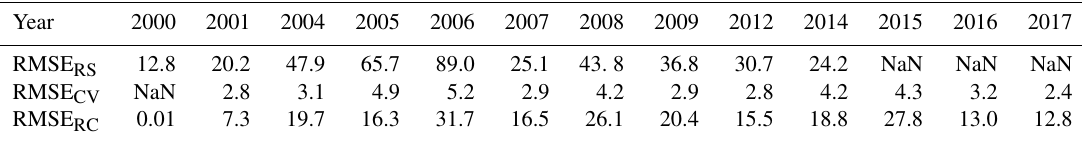
Figure 3. The aggregated in situ observational p CO 2 data in 0 . 5 ◦ × 0 . 5 ◦ grid boxes in the SCS in the 13 summers during the years 2000– 2017. Table 2. The RMSE between the remote-sensing-derived p CO 2 estimates and the observed underway p CO 2 data (RMSE RS ), of the cross- validation (RMSE CV ), and between the reconstructed p CO 2 and the observed underway p CO 2 data (RMSE RC ) (unit: